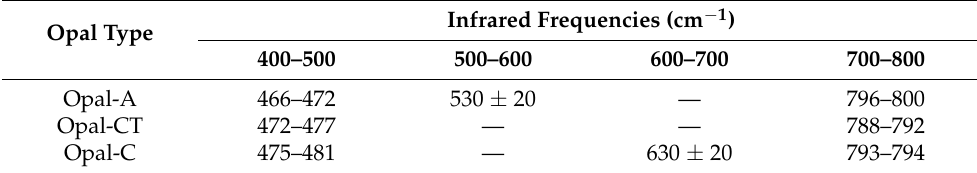
Table 3. Summary of infrared frequency variations in different opal types [8,9,20,21].